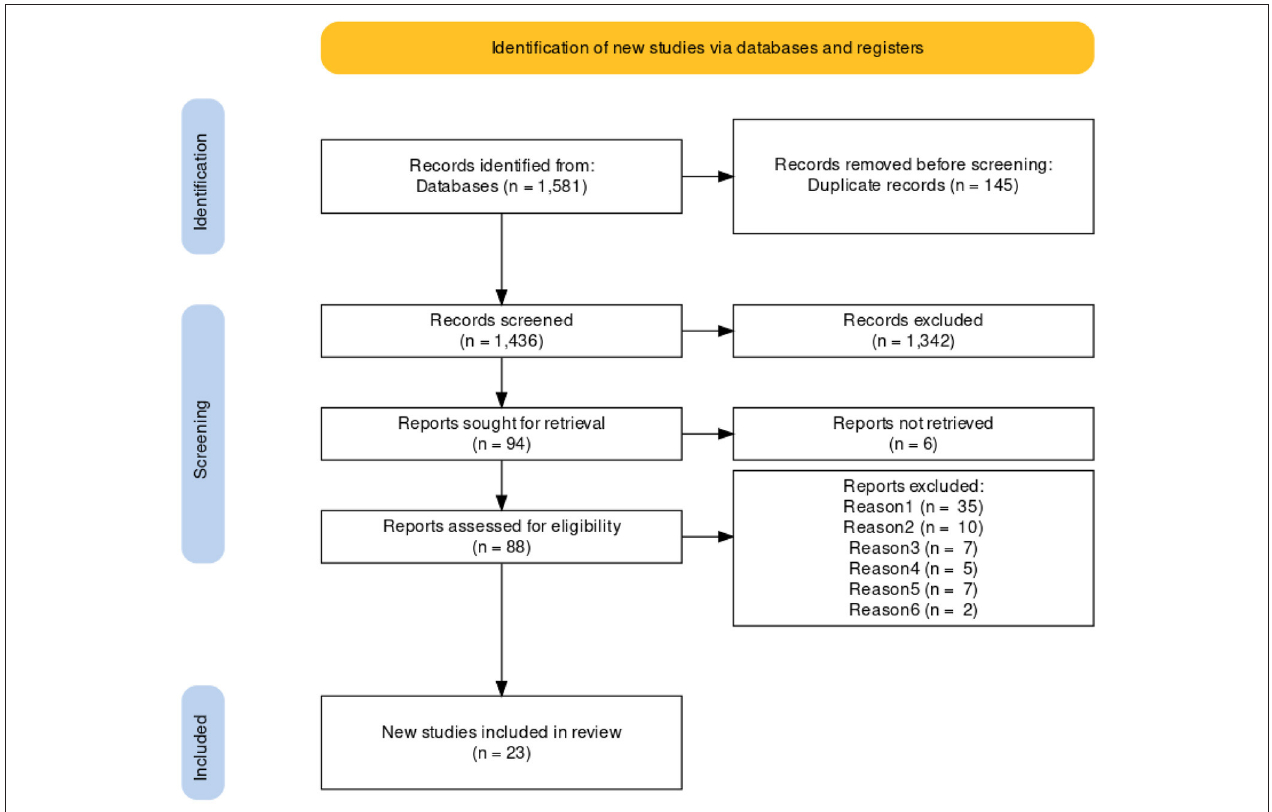
FIGURE 1 | PRISMA flow diagram of study inclusion and exclusion criteria for the systematic review, the detailed reasons are given in the